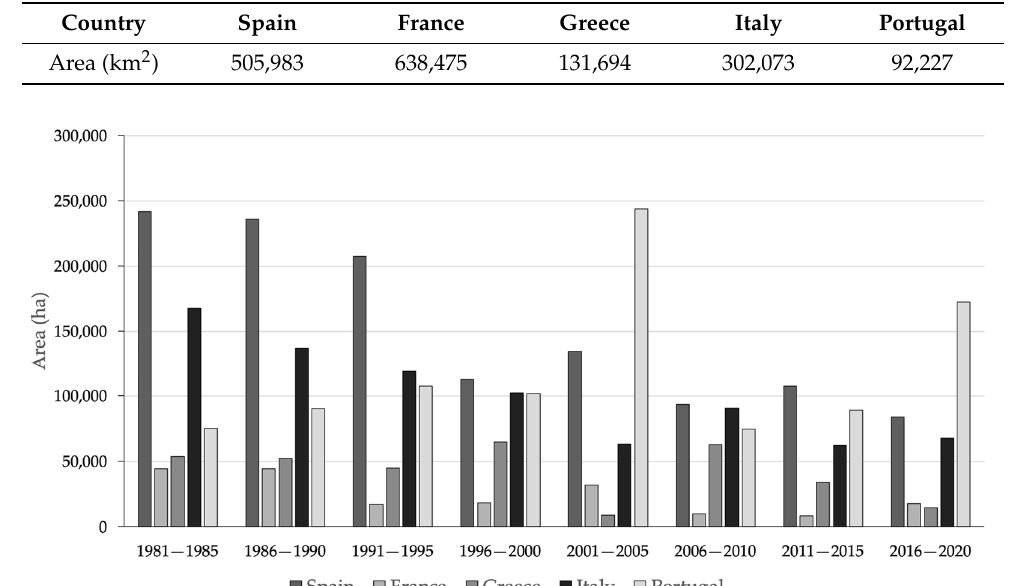
Table 2. Comparative Southern European countries area (adapted from http://www.pordata.pt, accessed on 14 December 2021).